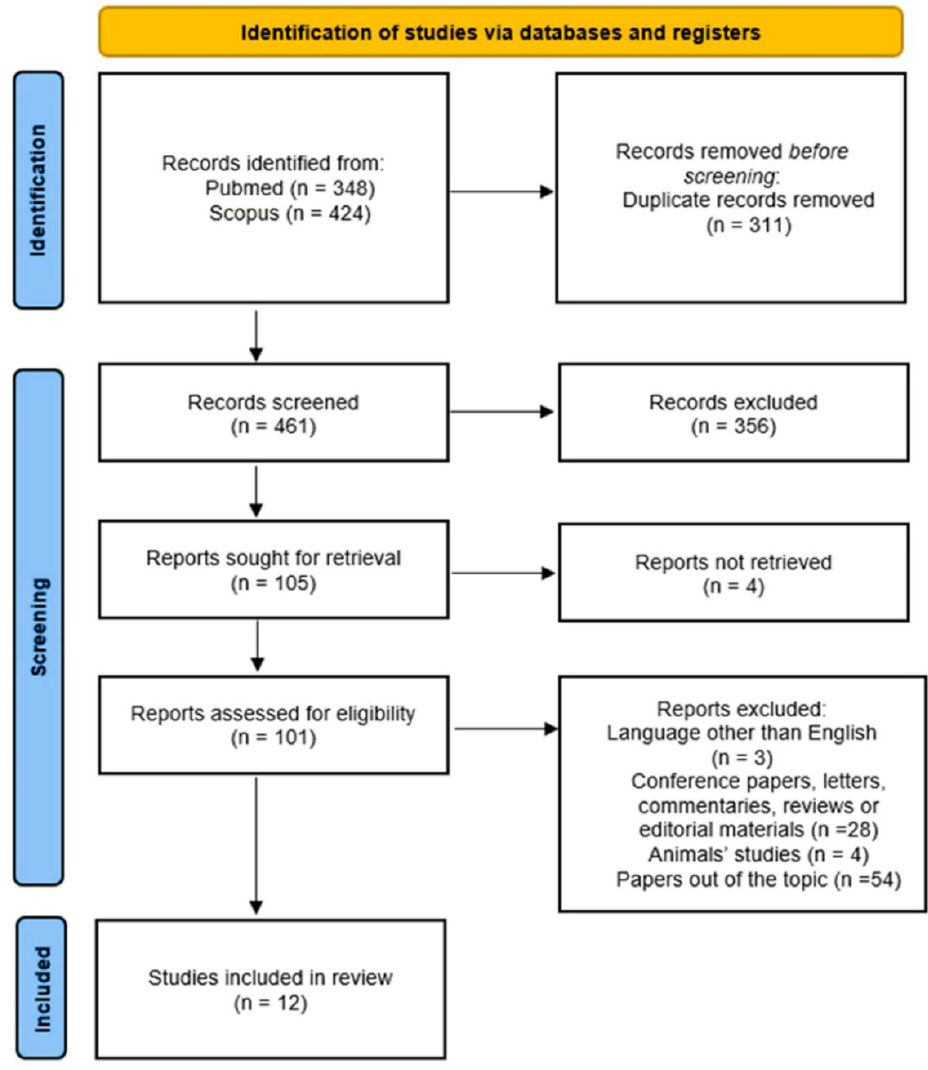
Figure 1. PRISMA flow diagram followed in this review.